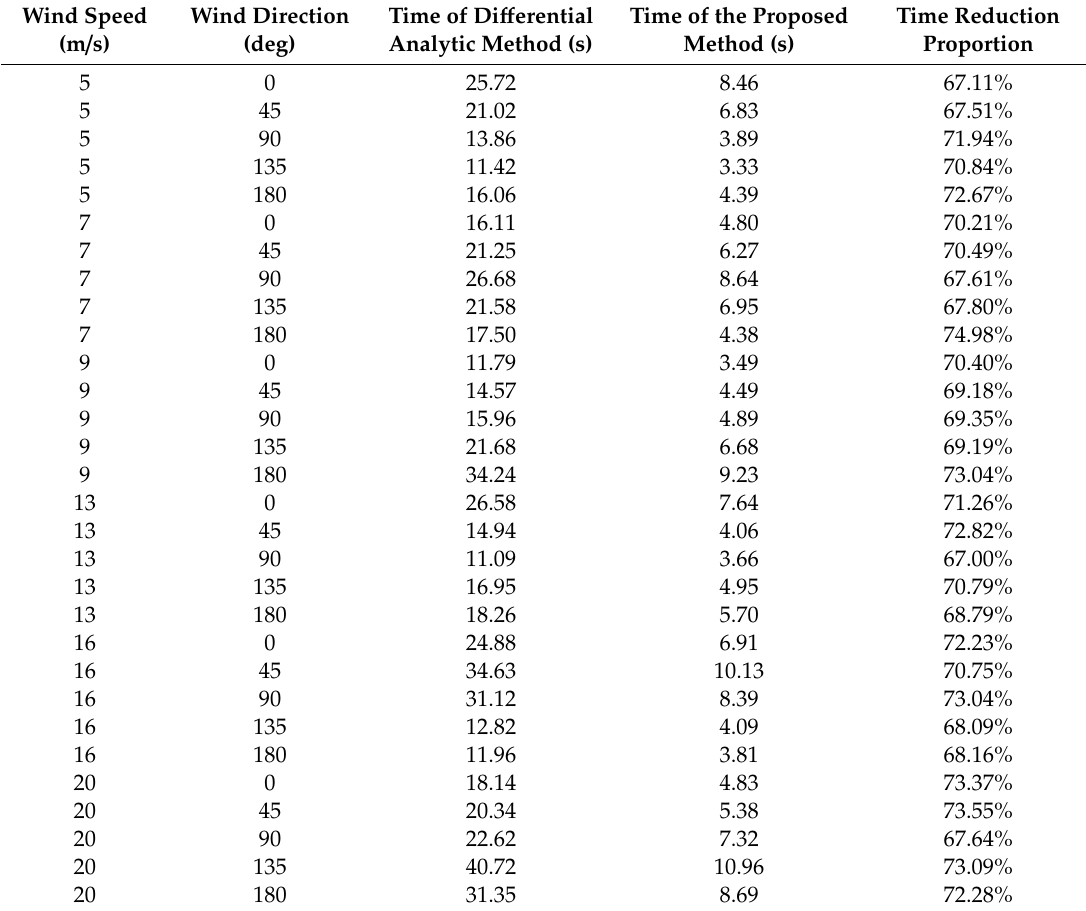
Table 4. Simulation time of the transmission of 1000 pulse